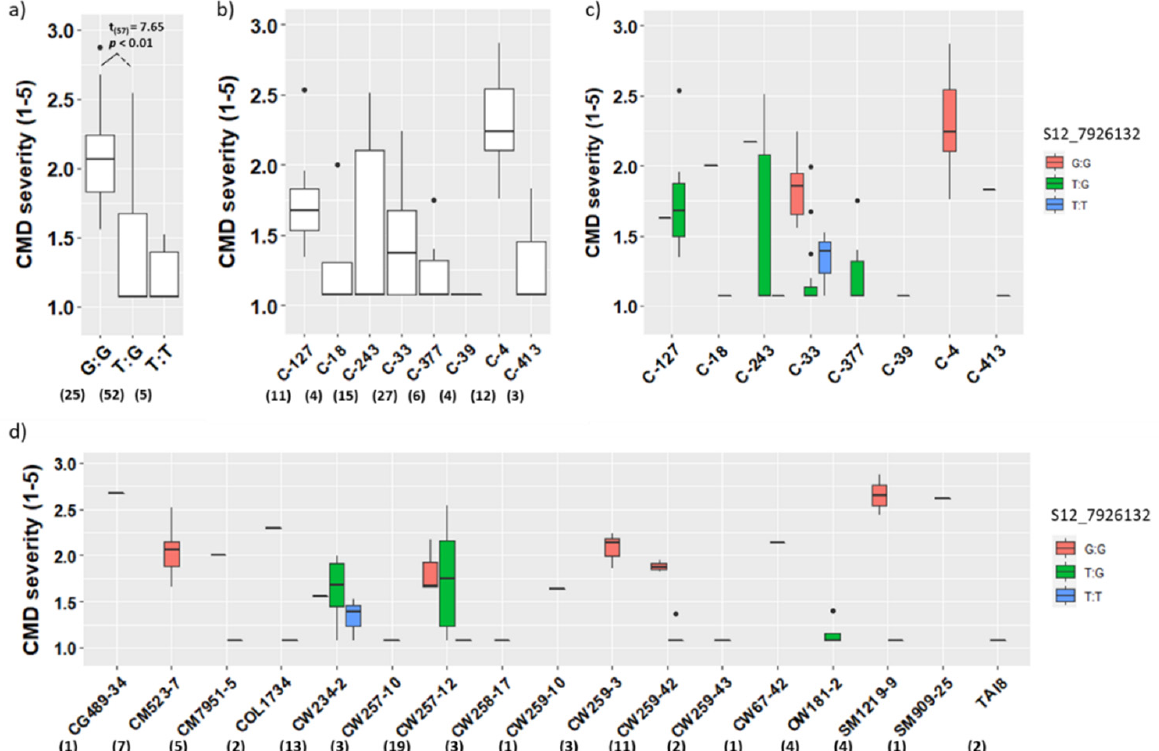
Figure 1. The CMD severity of the population CIAT102 grouped by the genotype of the marker S12_7926132 or family structure. ( a ) The CMD severity of the different genotypes at 3 months after planting. Among the 82 clones in CIAT102, 52 clones had the resistant allele T, and five clones are homozygous with the resistant allele. Significant difference among the clones with and without the resistant allele was observed (mean of CMD severity scores 1.4 vs. 2.1, respectively). All the 25 clones without the resistant allele T showed CMD symptoms. ( b ) The CMD scores of the CIAT102 clones grouped by the donor parents of CMD resistance. C-127 and C-4 did not produce progeny with CMD resistance. ( c ) The CMD severity of the CIAT102 clones grouped by their genotype and the donor parents of CMD resistance. Except for C-4, all other donor parents produced progeny with the resistant allele T, but the resistant allele T did not provide CMD resistance in the progeny of C-127. ( d ) The CMD severity of the CIAT102 clones grouped by their genotype and other progenitors. The progeny of CW234-2 and CW257-12 showed segregation in CMD resistance even though containing the resistant allele T.